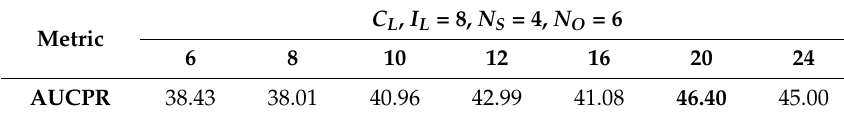
Table 2. The AUCPR (%) results of parameter CL.